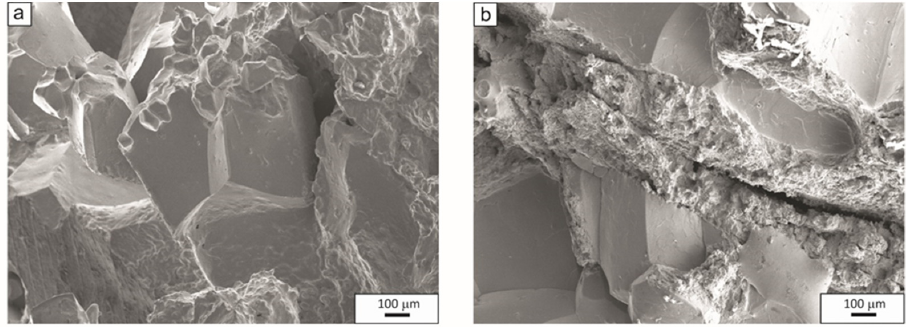
Figure 11. Fracture surfaces of samples of 27Mn-4Si-2Al-Nb steel after tensile test at temperatures NDT = 1235 °C ( a ) and DRT = 1220 °C ( b ). NDT = 1235 ◦ C ( a ) and DRT = 1220 ◦ C ( b